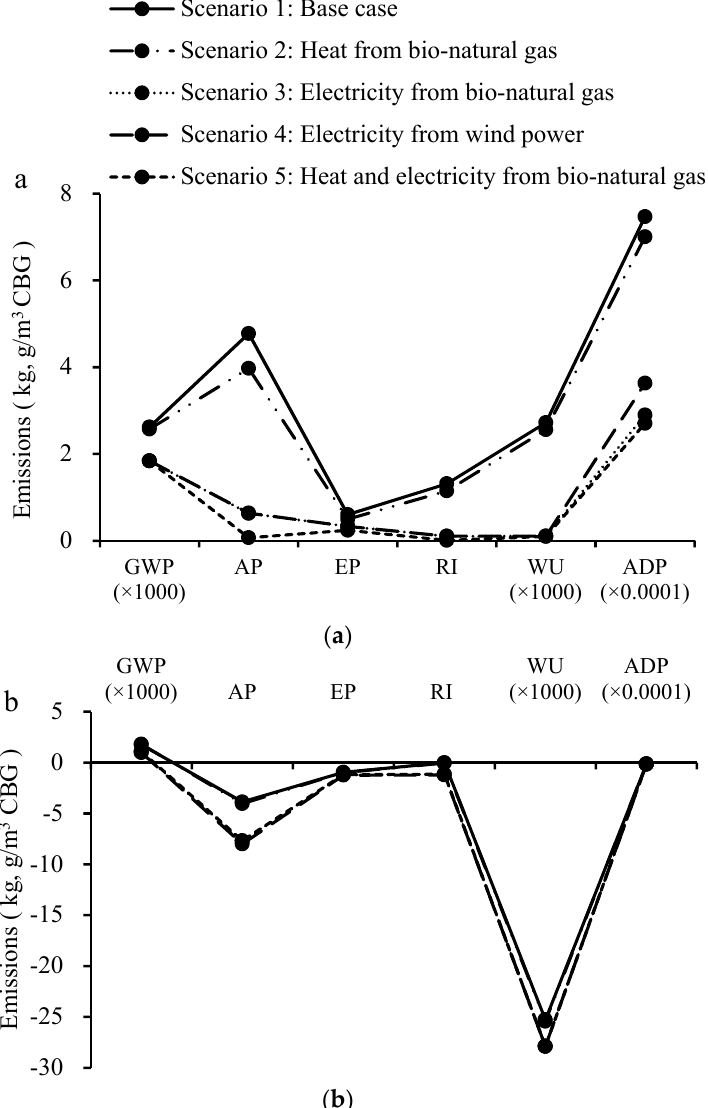
Figure 4. Sensitivity analysis of global warming potential (GWP, kg CO 2 -eq), acidification potential (AP, g SO 2 -eq), eutrophication potential (EP, g PO 43 − -eq), respiratory inorganics (RI, g PM 2.5 -eq), water use (WU, kg), and abiotic depletion potential (ADP, g Sb-eq) for different scenarios (A: without considering emission credits; B: with considering emission credits).